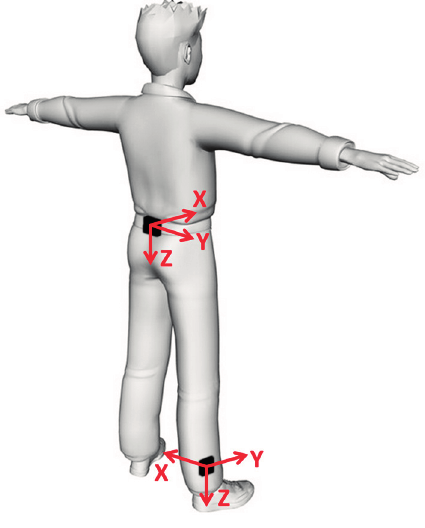
Figure 1. Sensor location and axes orientation of the two Magneto-Inertial Measurement Units (MIMUs) attached on the volunteer’s body (adapted from